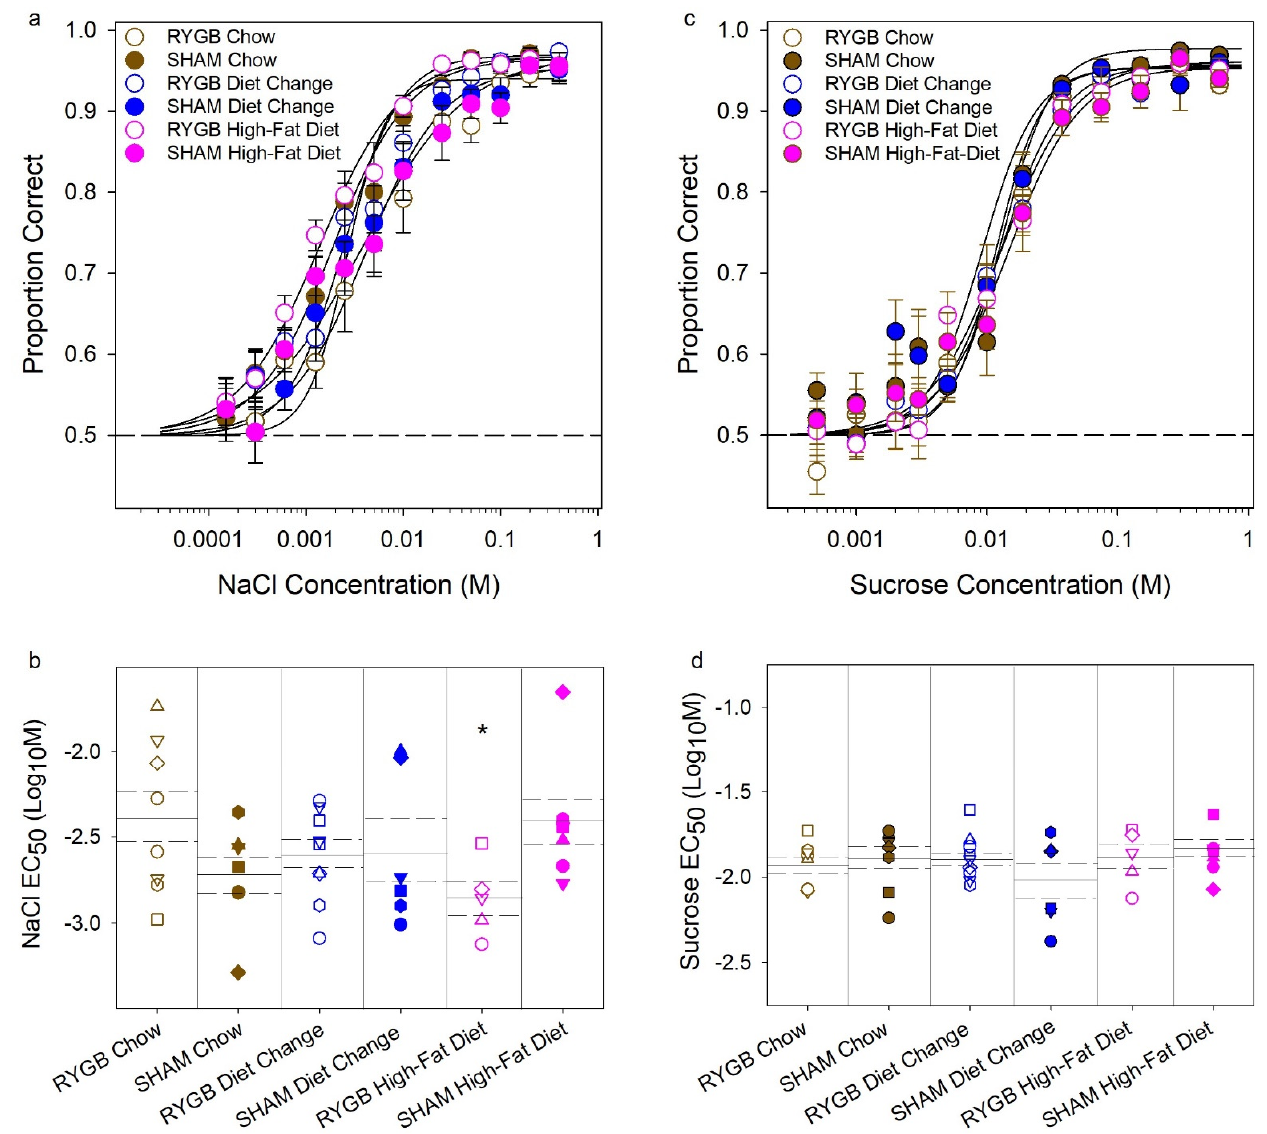
Figure 5. Mean ( ± SE) proportion correct as a function of stimulus concentration for NaCl ( a ) and sucrose ( c ) for each of the groups. Curve fits reflect group averages for individual data based on the 3-parameter logistic function described in Data Analysis . Individual EC 50 values for NaCl ( b ) and sucrose ( d ) were also calculated using this logistics function. Means for each diet condition are noted by the solid line; SE, dashed lines. RYGB animals are represented by open circles and SHAMs by filled circles. Brown symbols represent the Chow group; blue, the diet change; pink, the high-fat diet. “*” reflects a significant effect of surgery within a given diet condition as assessed by paired comparison; no comparisons survived Bonferroni